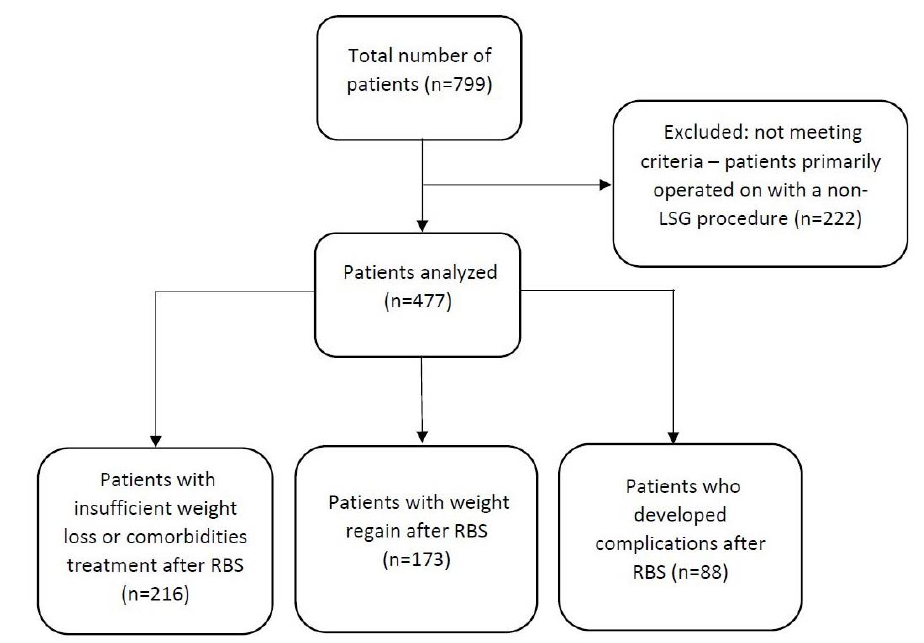
Figure 1. Flowchart of patients in the study.